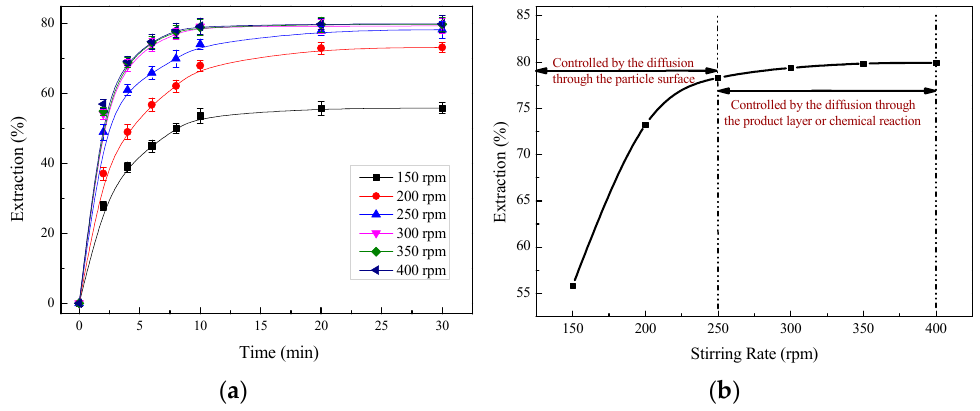
Figure 6. The effect of the stirring rate on the zinc extraction: ( a ) time difference; ( b ) 30 min of leaching.